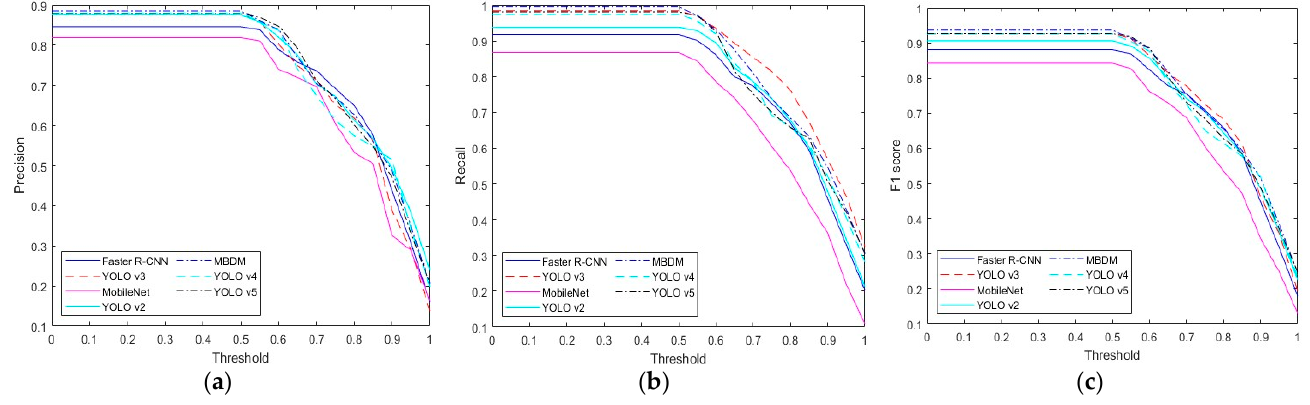
Figure 7. Performance comparison graph for each method according to IoU threshold in multina- tional banknote database: ( a ) precision, ( b ) recall, and ( c ) F1 score.